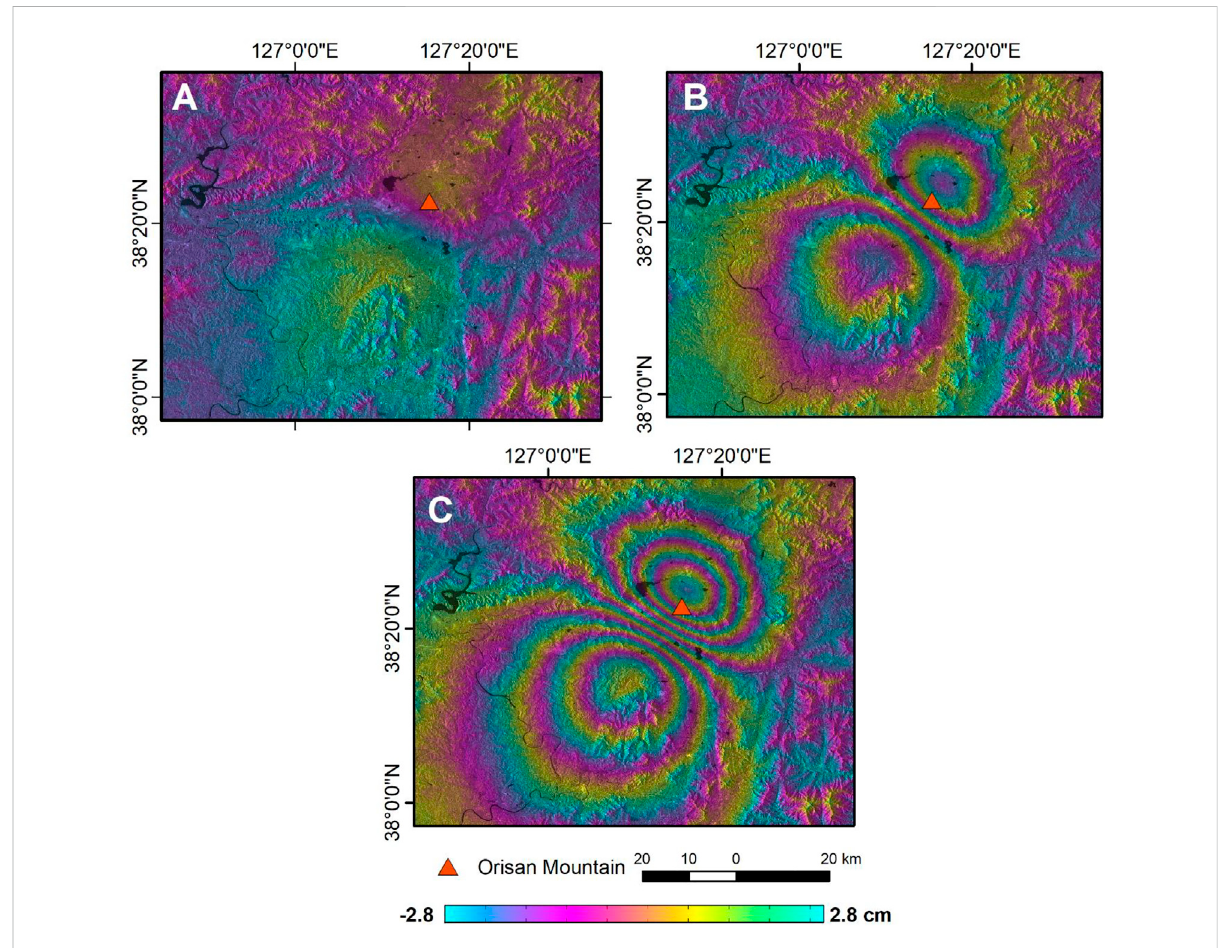
Synthetic interferogram results of the Orisan Mountain with different VEIs: (A) VEI 1, (B) VEI 2, and (C) VEI